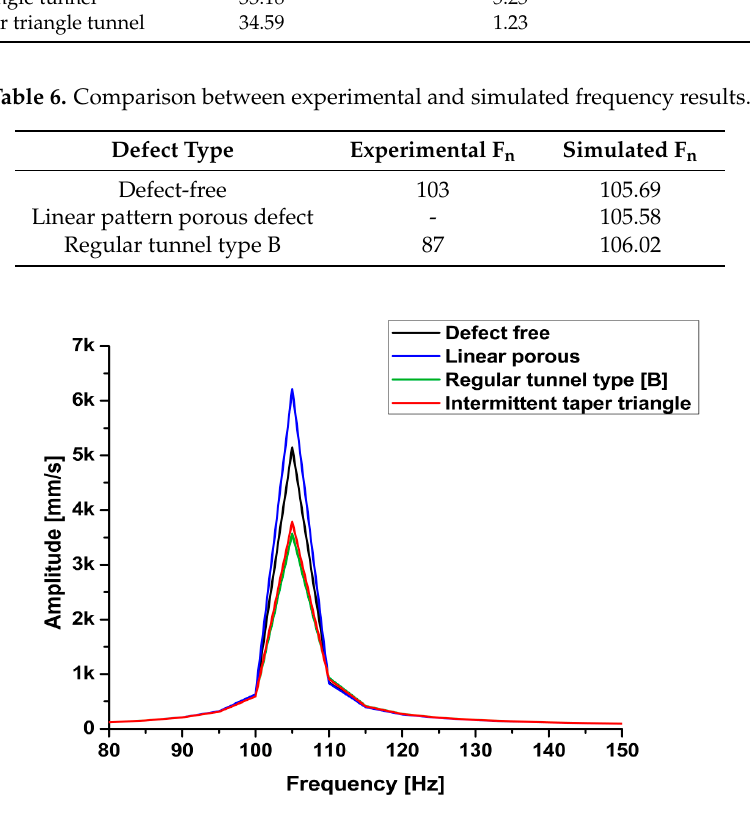
Table 5. Investigated defect types and properties with corresponding frequencies.